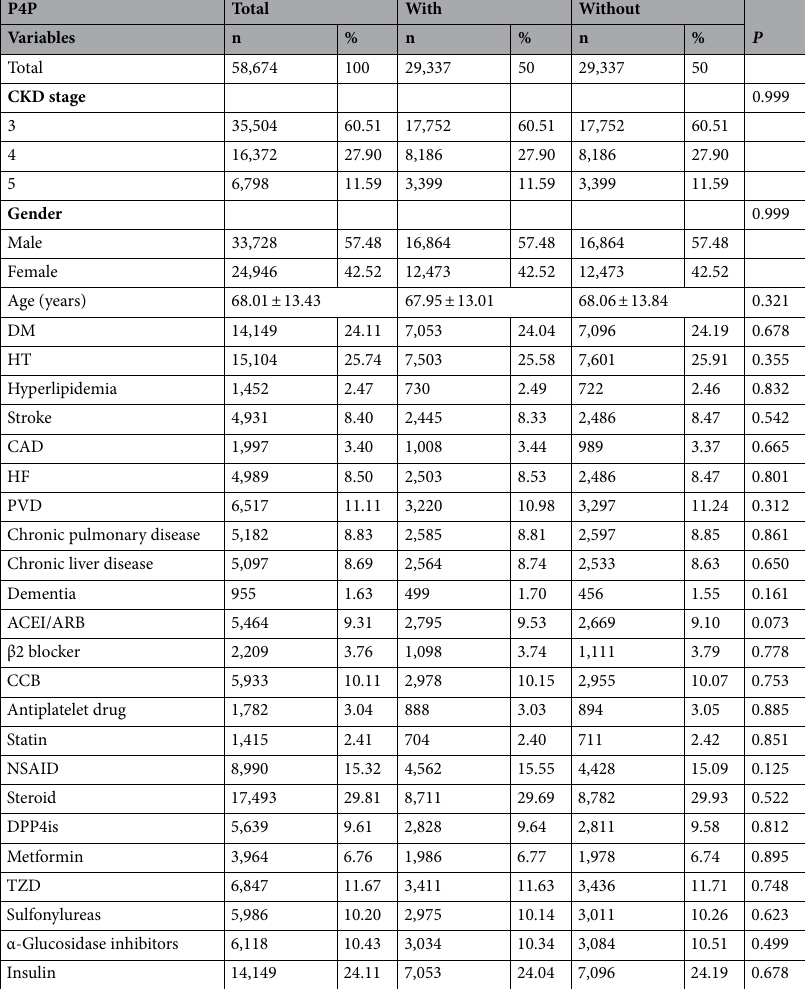
Table 1. Baseline characteristics of study subjects. *P < 0.05; statistical significance. Abbreviations CAD = coronary artery disease; CKD = chronic kidney disease; DM = diabetes mellitus; HT = hypertension; HF = heart failure; PVD = peripheral vascular disease; P4P = pay for performance program; ACEI = angiotensin-converting enzyme inhibitors; ARB = angiotensin receptor blockers; CCB = calcium channel blocker; NSAID = nonsteroidal anti-inflammatory drugs; DPP4is = dipeptidyl peptidase-4 inhibitors; TZD =